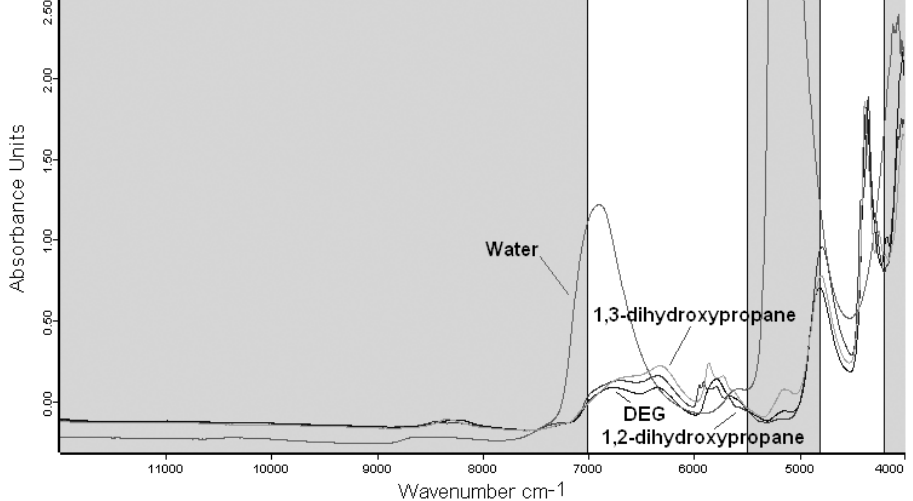
Fig. 1. Spectral ranges in the identi¯cation method for DEG raw material (white